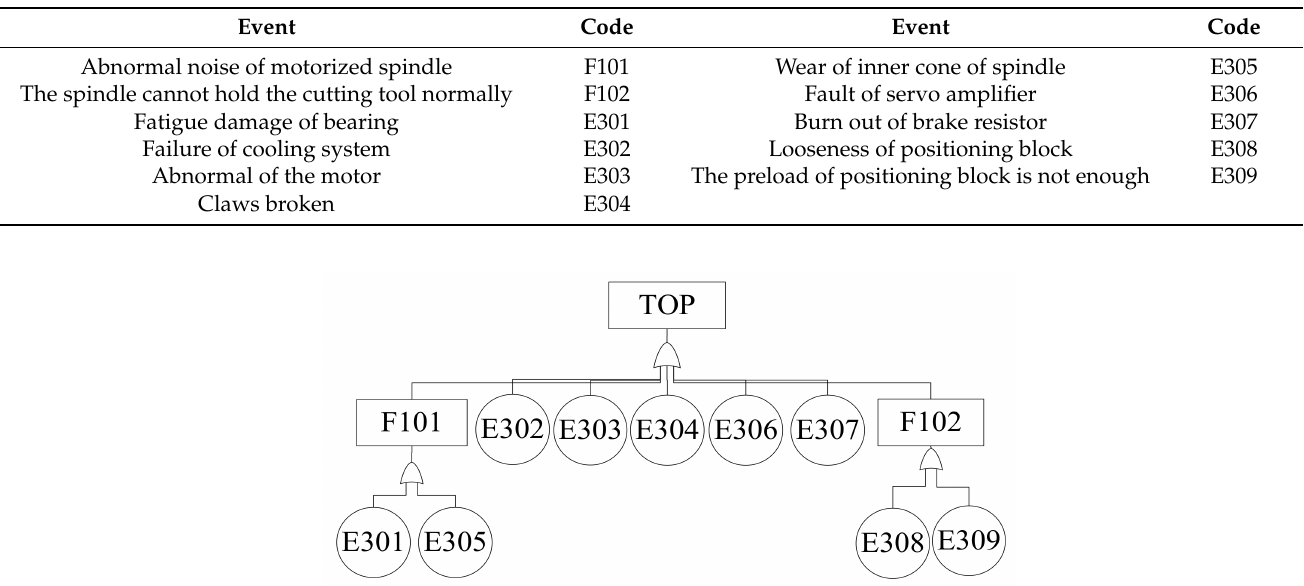
Table 2. Result event label of top event TOP.